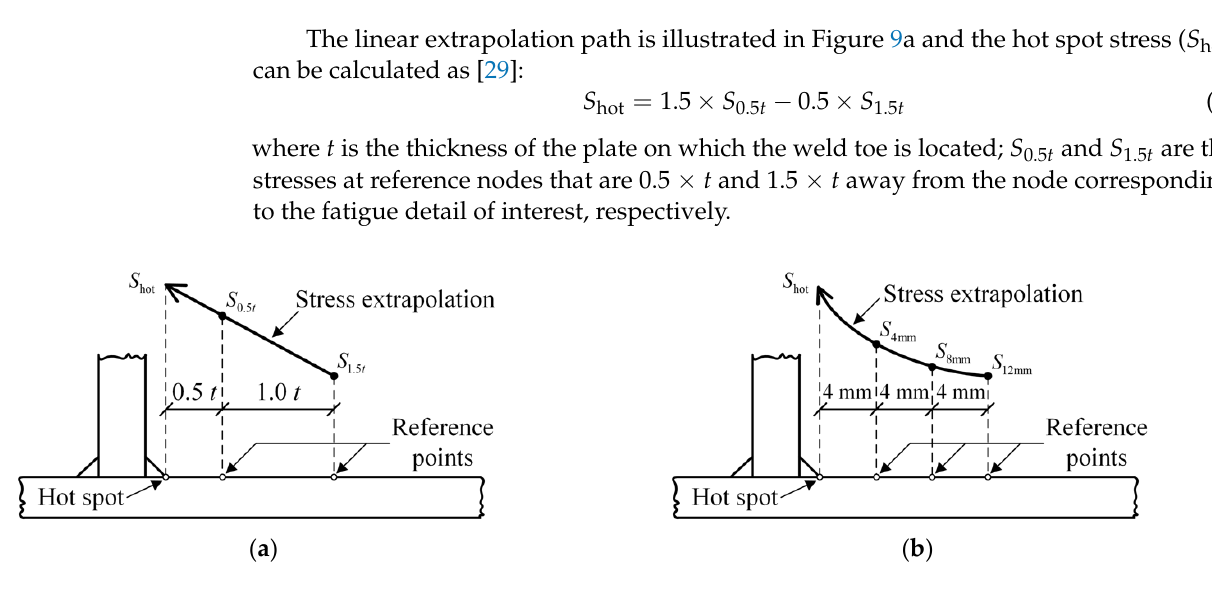
Figure 9. Surface stress extrapolation of hot spots: ( a ) Linear extrapolation; ( b ) Quadratic ex ‐ trapolation.